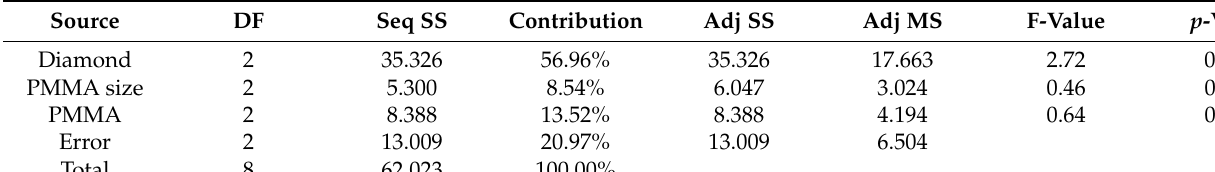
Table 6. ANOVA variance table for energy absorption capacity.